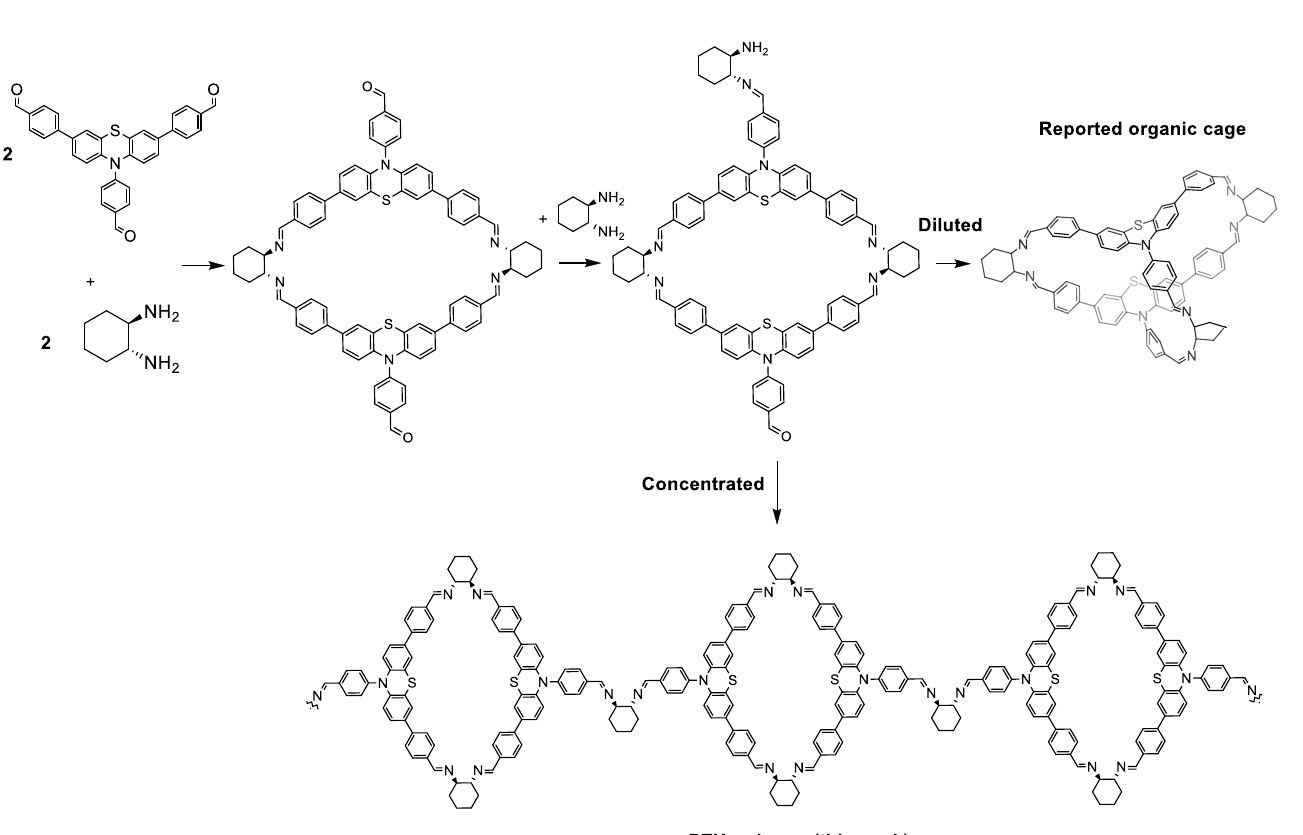
Scheme 1. Formation conditions for both molecular cage and PTH-polymer.